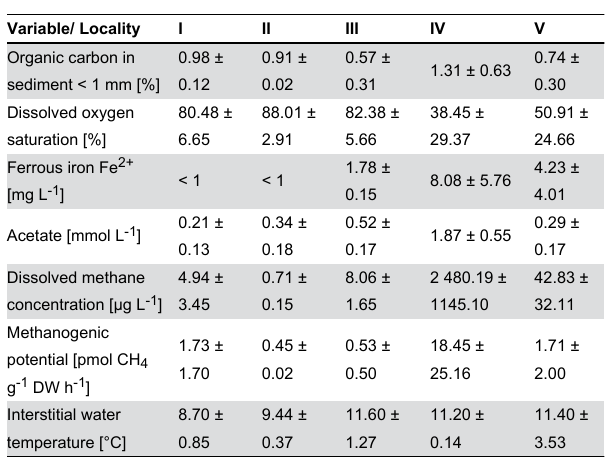
Table 1. Selected physico-chemical parameters (annual means 2009-2010) of the hyporheic interstitial water and sediment along the longitudinal stream profile (average ± SD).